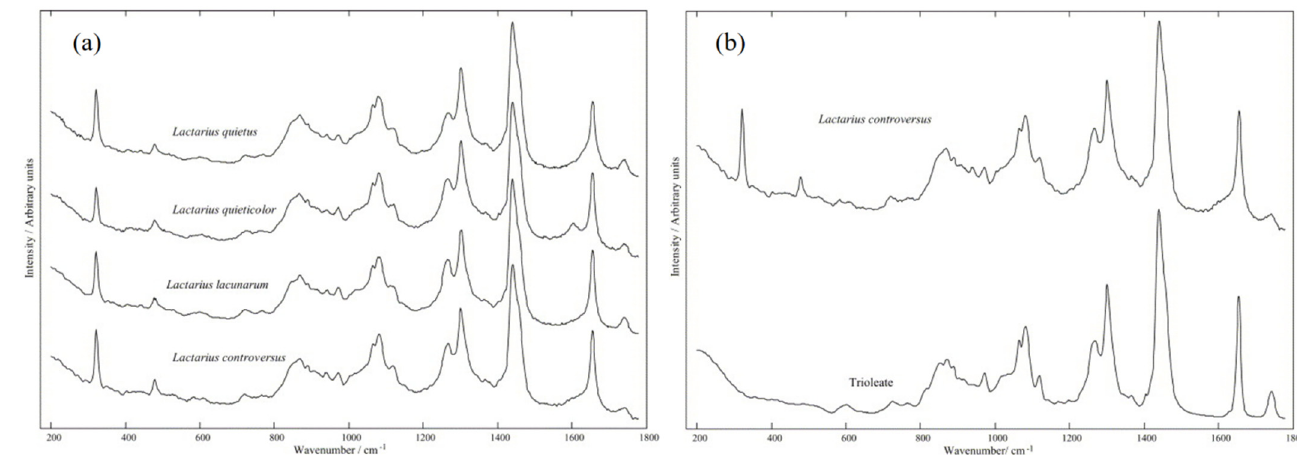
Figure 1. ( a ) Average spectra of amylopectin, amylose, cellulose and chitin polysaccharides; ( b ) Mean spectra of control Lactobacillus and trioleic acid. ( a , b ) Reproduced with permission of Ref. [25]. Copyright 2004, published by Elsevier B.V.